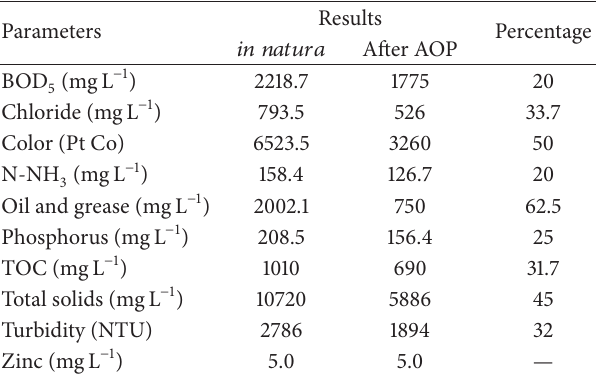
Table 2: Physical-chemical results for dairy effluent before and after AOP treatment.